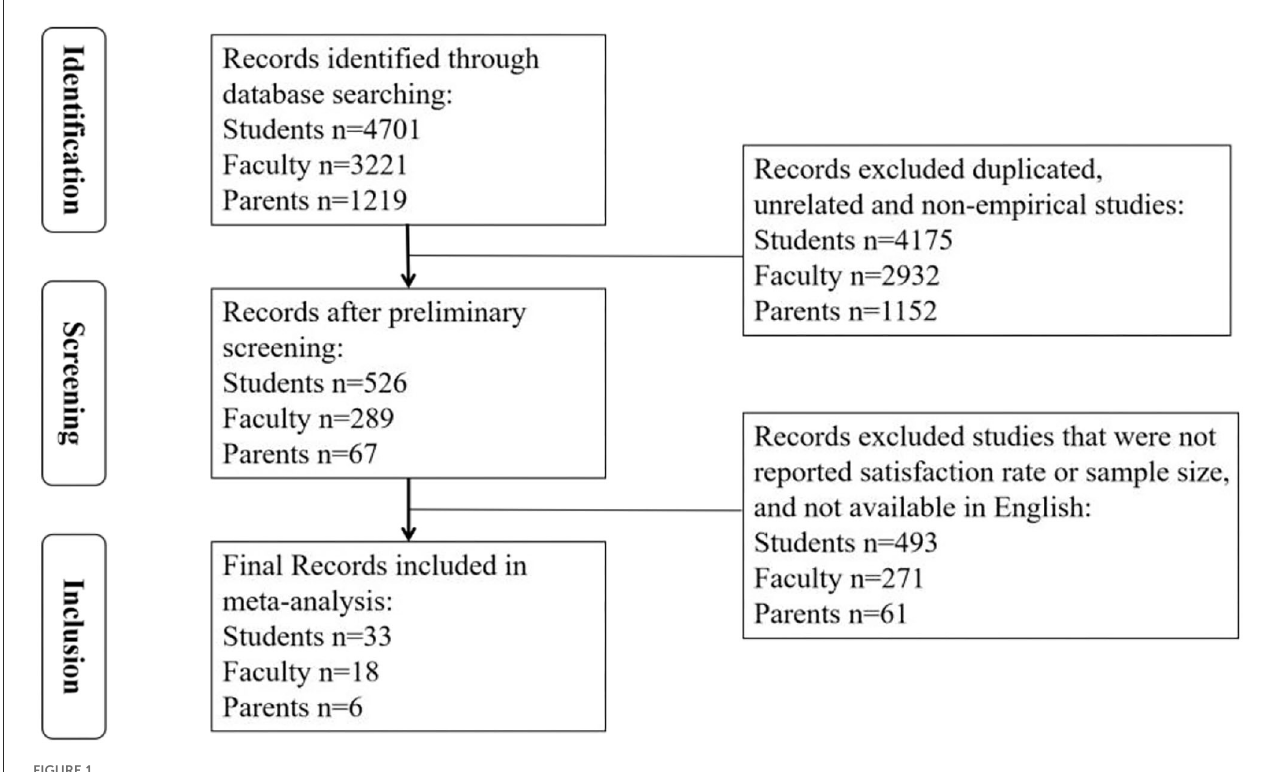
FIGURE1 A flow diagram of Literature Searching and Screening.